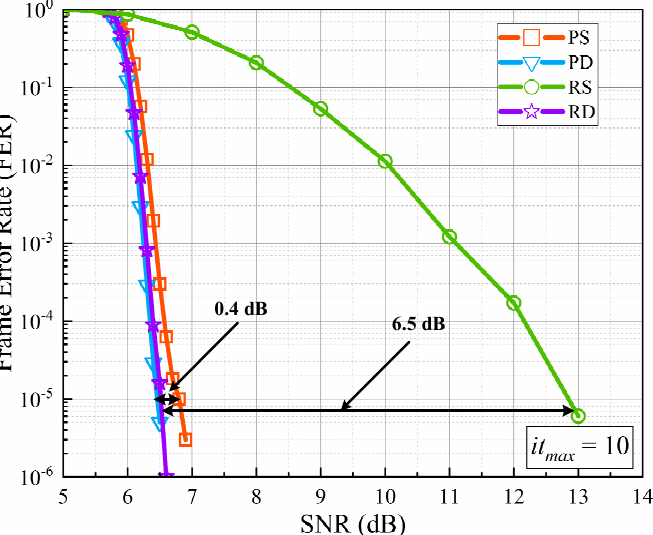
Figure 6. The SNR performance of different schedules. PS: Priority-based decoder with a single update queue. PD: Priority-based decoder with double update queues. RS: Residue-based decoder with a single update queue. RD: Residue-based decoder with double update queues.